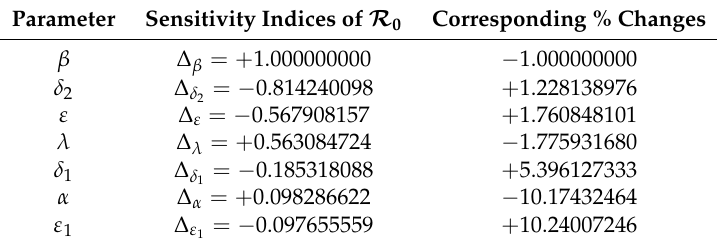
Table 2. Sensitivity indices of R 0 , ∆ p , and corresponding % changes in p i to decrease R 0 by 1%. i Parameter Sensitivity Indices of R 0 Corresponding % Changes β ∆ β = +